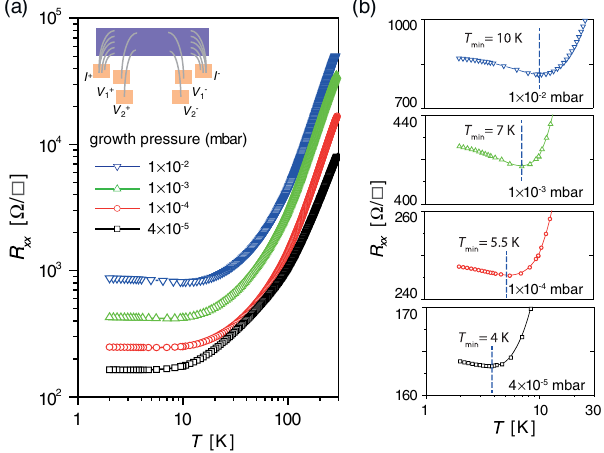
FIG. 1. (a) Sheet resistance R xx obtained at zero field ( B ¼ 0 T) for NGO/STO heterostructures grown at various p . (b) R xx in dep the low-temperature regime: A slight resistance upturn is ob- served for all samples, while the temperature of minimum resistance T scales with p min dep